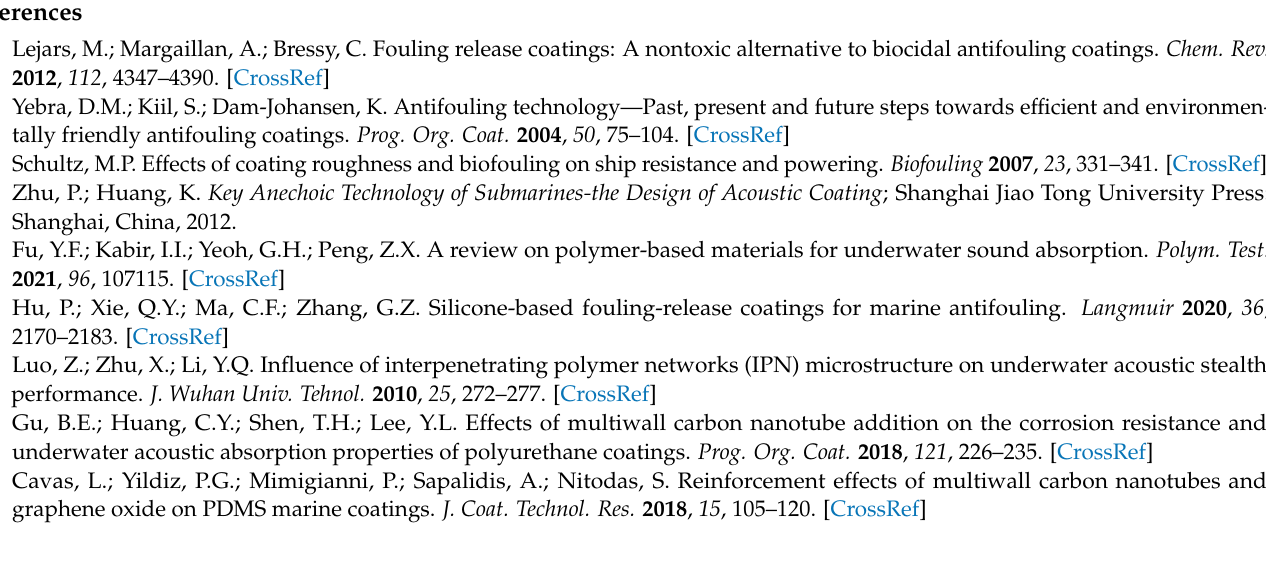
Figure S3: EDS analysis of PDMS (A), PCSi1 (B), PCSi3 (C), PCSi5 (D); Table S1: The contents of different elements collected by